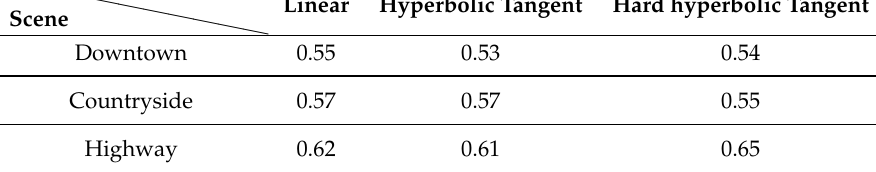
Table 3. Analysis of attention performance in different scenes and different activations. The average speeds are 30.77 km/h, 50.40 km/h, and 78.76 km/h for downtown, countryside, and highway scenes, respectively.